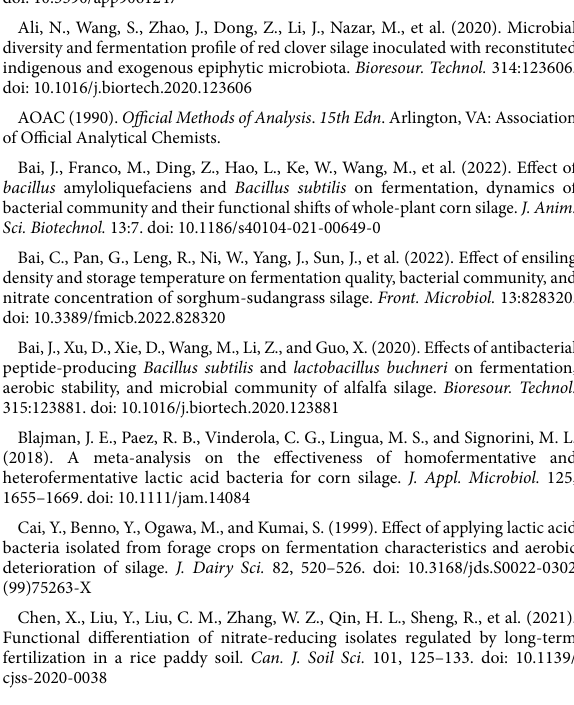
SUPPLEMENTARY FIGURE S1 Differences in bacterial community on genus levels in sorghum- sudangrass silage after ensiling for 1 (A) , 3 (B) , 7 (C) , 15 (D) , and 40 (E)